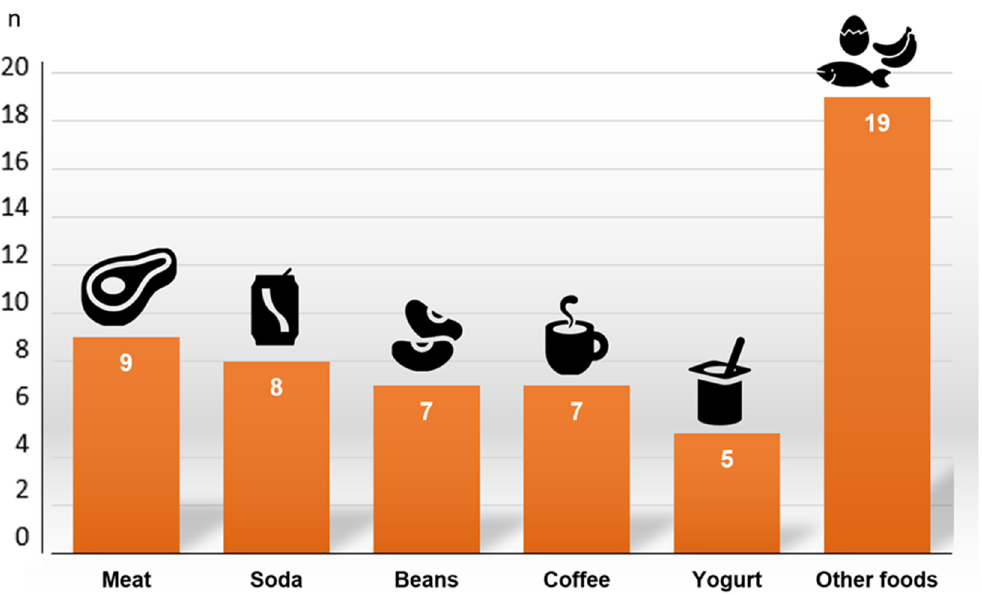
Figure 1. Aversion-causing foods reported by breast cancer patients undergoing adjuvant chemotherapy. Table 3. Association between dietary antioxidant capacity (DaC), diet quality according to the Brazilian Healthy Eating Index Revised (BHEI-R) and oxidative stress biomarkers and non-occurrence of food aversions (n =